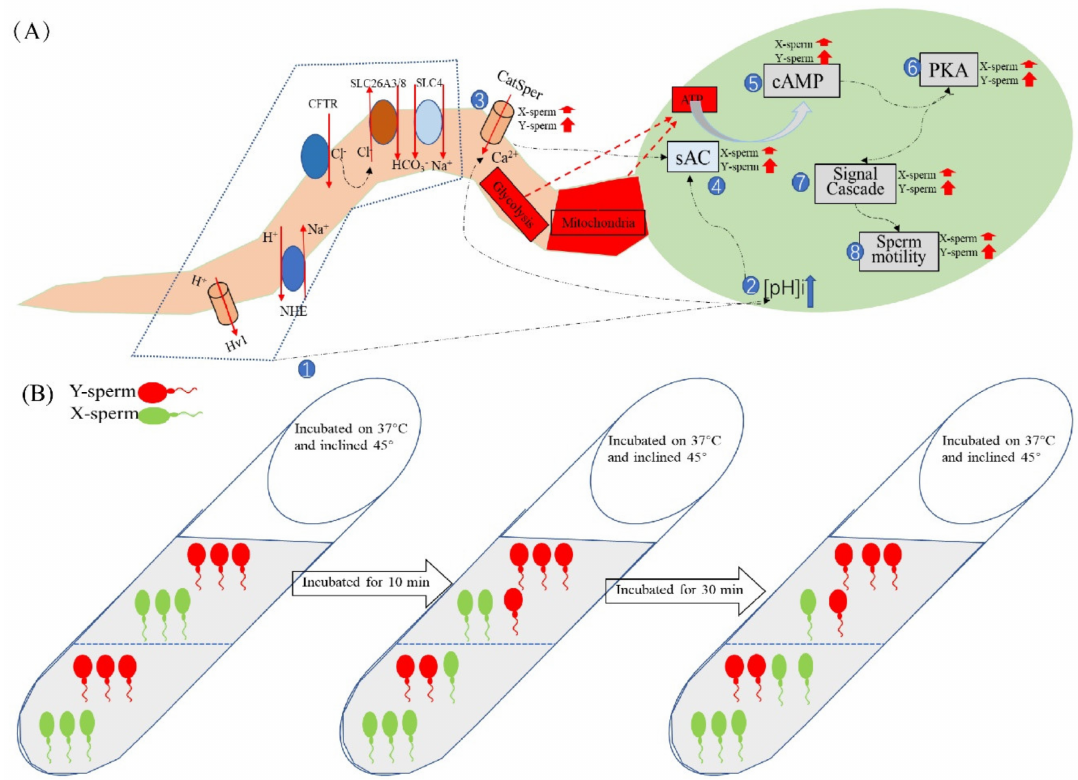
Figure 10. Schematic diagram of the mechanism by which diluent pH affects sperm motility. ( A ) Changes in pHi, [Ca 2+ ]i concentration, and motility-related protease activity of X/Y-chromosome- bearing sperm during incubation in the alkaline diluent, with numbers indicating the order of changes within sperm. ( B ) Dairy goat sperm samples were incubated with pH7.4 dilution, the tubes were tilted at 45 ◦ and placed in a 37 ◦ C incubator. The pHi of the sperm was about 5.0 at 0 min, and the ratio of X/Y-chromosome-bearing sperm in the upper and lower layers of the test tube was equal. The pH of the sperm increased to 6.9 after 10 min of incubation and remained unchanged thereafter, with a higher proportion of sperm in the lower layer than in the upper layer. When incubated for 40 min, the number of sperm in the lower layer and the proportion of X-chromosome-bearing sperm were significantly higher than those in the upper